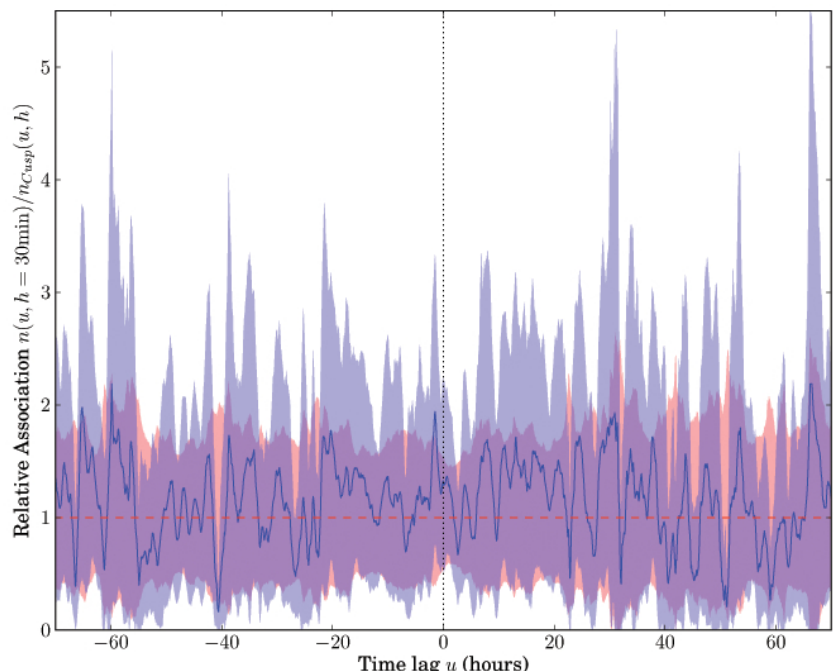
Fig. 2. Association of CEPs (blue) and cusp (red) with storm onsets identified from Dst ∗ . Normalized to match asymptotic association numbers and so cusp association is 1.0. Lines represent the calculated association number; shaded areas indicate 95% confidence intervals; overlapping c.i. are magenta.